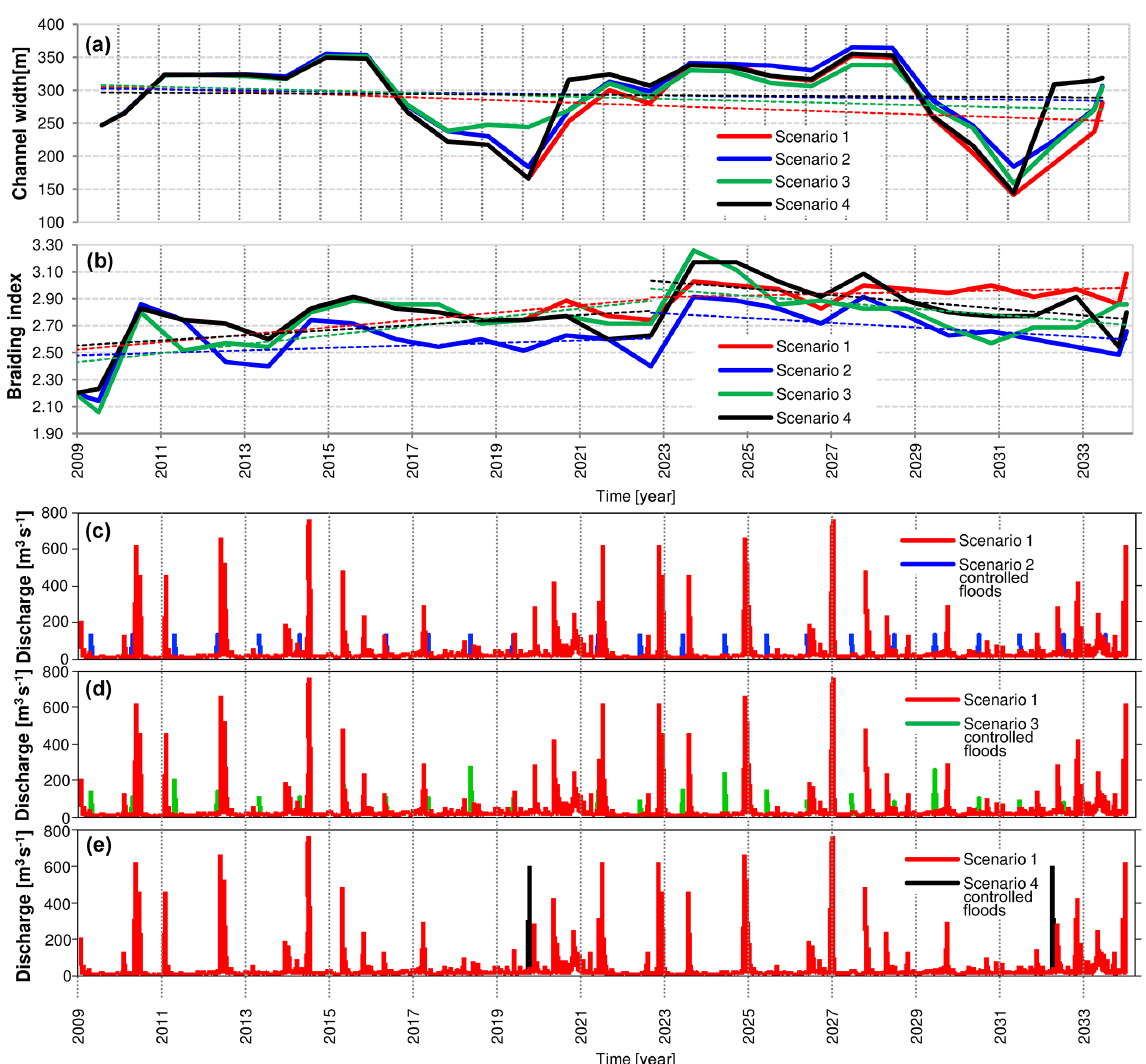
Figure 7. Scenario results expressed in terms of channel width (a) and braiding index (b) variations, coupled to the simulated upstream inflow series with controlled-flood releases: (c) scenarios 1 and 2, (d) scenario 3 and (e) scenario